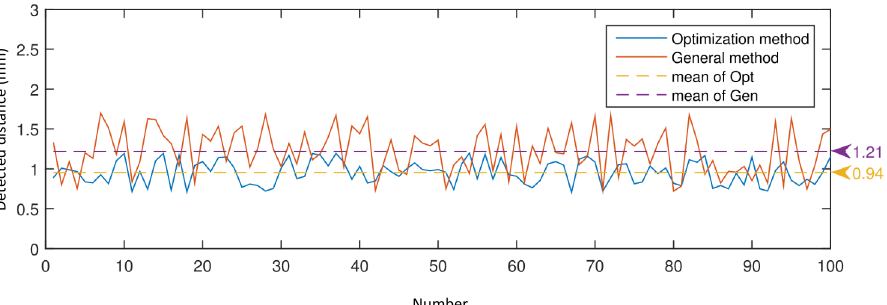
Figure 11. Detection precision comparison of the EKF based self-adaptive MP method and general one for 100 rounds. The thickness of each foreign body was arbitrary. Through 100 experiments, the average detected distance of the proposed method was 0.94 mm, while that of the general one was 1.21 mm. Namely, the detected distance of the proposed method was decreased by